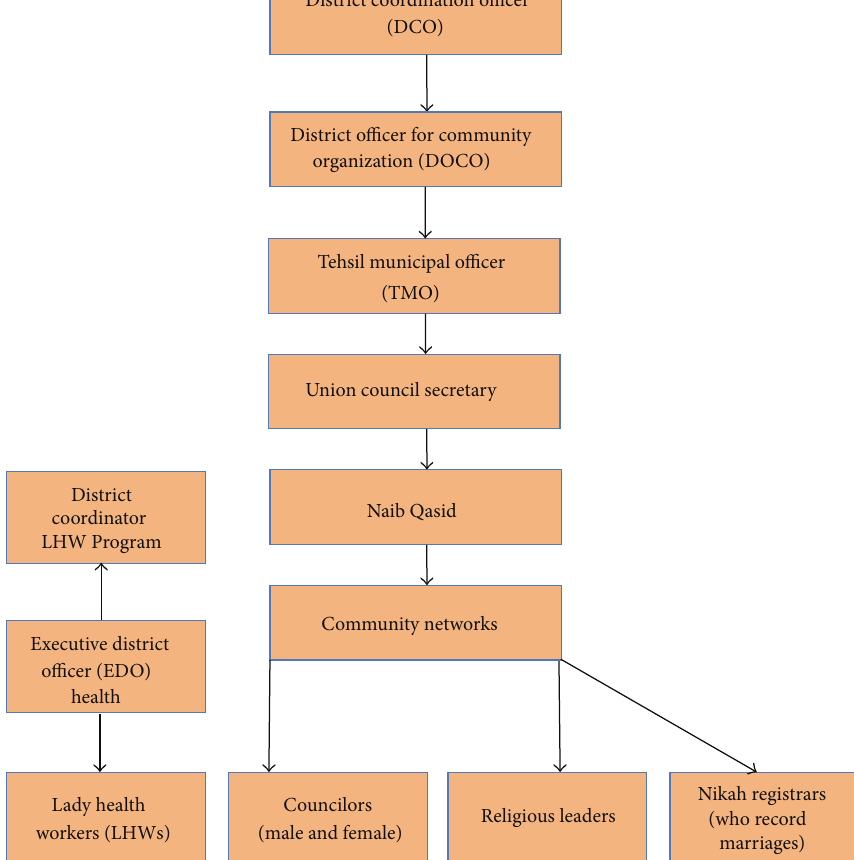
Figure 1: Organizational structure: from union council to district